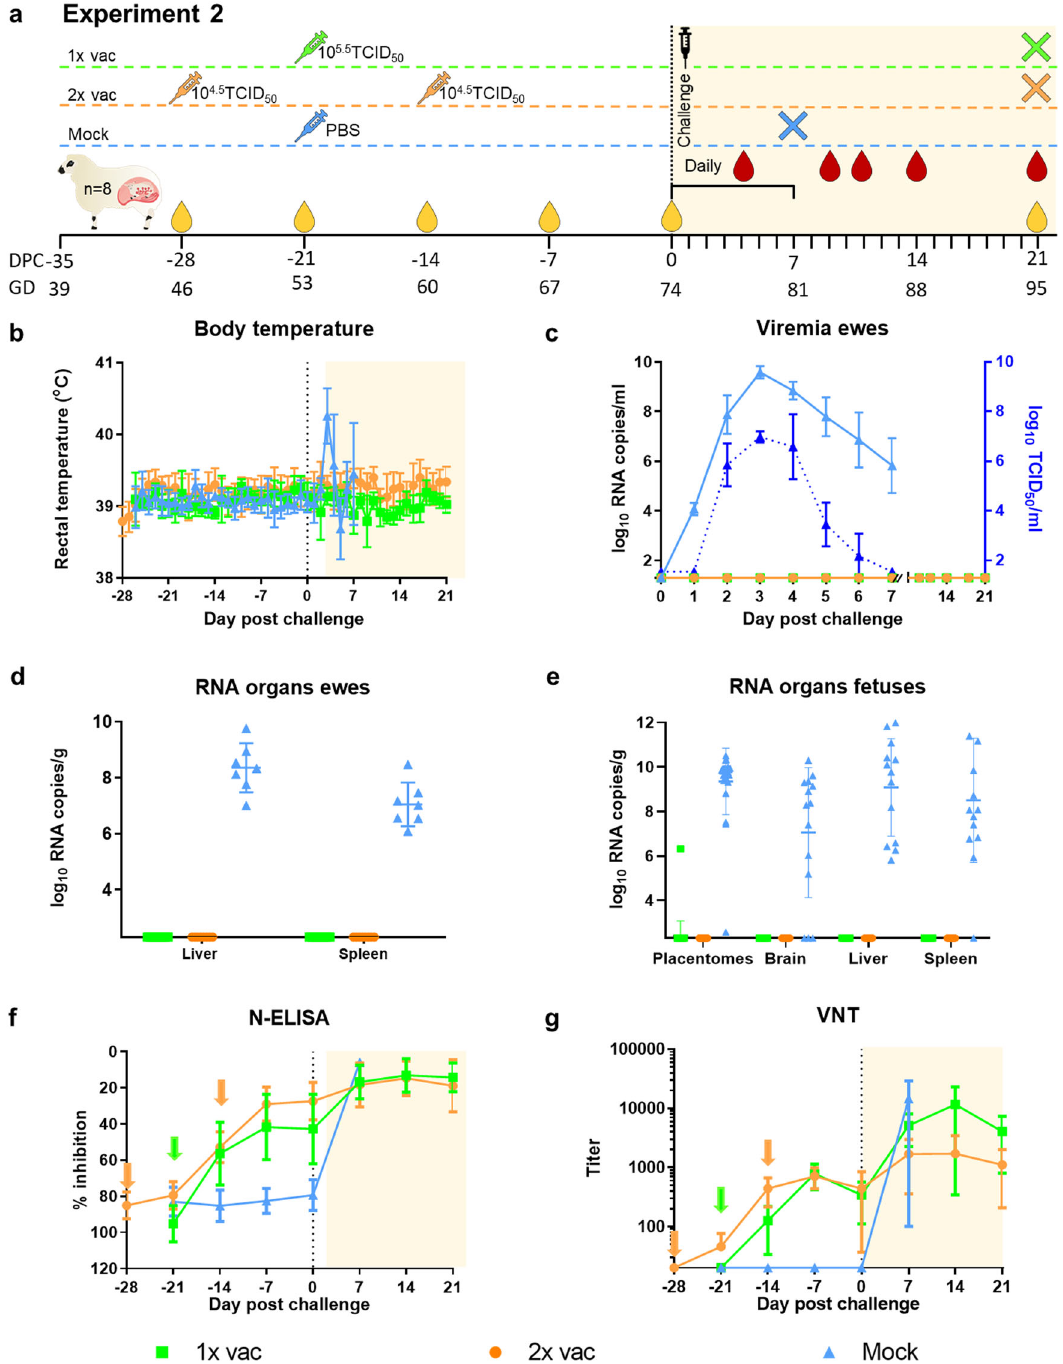
Fig. 3 Primary outcome parameters of vaccination challenge Experiment 2. a Experimental design. Pregnant ewes were vaccinated either once or twice at the time points indicated and challenged two weeks (double vaccination) or three weeks (single vaccination) after vaccination with highly virulent RVFV strain 35/74. Vaccinated/challenged ewes were euthanized 21 days post challenge. One ewe in the mock group succumbed on day 5, whereas the other ewes were euthanized at 7 DPC. b Rectal temperatures in °C. c Monitoring of viral RNA by RT-qPCR (detection limit 1.3 log 10 RNA copies/ml). Samples with an RNA copy number of >10 5 /ml were assayed for viremia by virus isolation on BHK cells (detection limit of 1.55 log 10 TCID 50 /ml). d Detection of viral RNA in liver and spleen samples of the ewes (detection limit 2.3 log 10 RNA copies/gram). e Detection of viral RNA in placentomes, brains, liver and spleens of foetuses (detection limit 2.3 log 10 RNA copies/gram). Of each placenta, two placentomes were tested. f Detection of anti-N antibodies by competition ELISA in weekly obtained sera. Competition is expressed as percentage inhibition ratio of the optical densities (OD) of the sample and the OD of the negative control (% S/N). All values below 40% are considered positive, between 40 and 50% are considered doubtful and above 50% are considered negative. g Detection of neutralising antibody responses by VNT. Moments of vaccination are indicated in panels f and g by arrows. Measurements were taken from distinct samples. Error bars represent